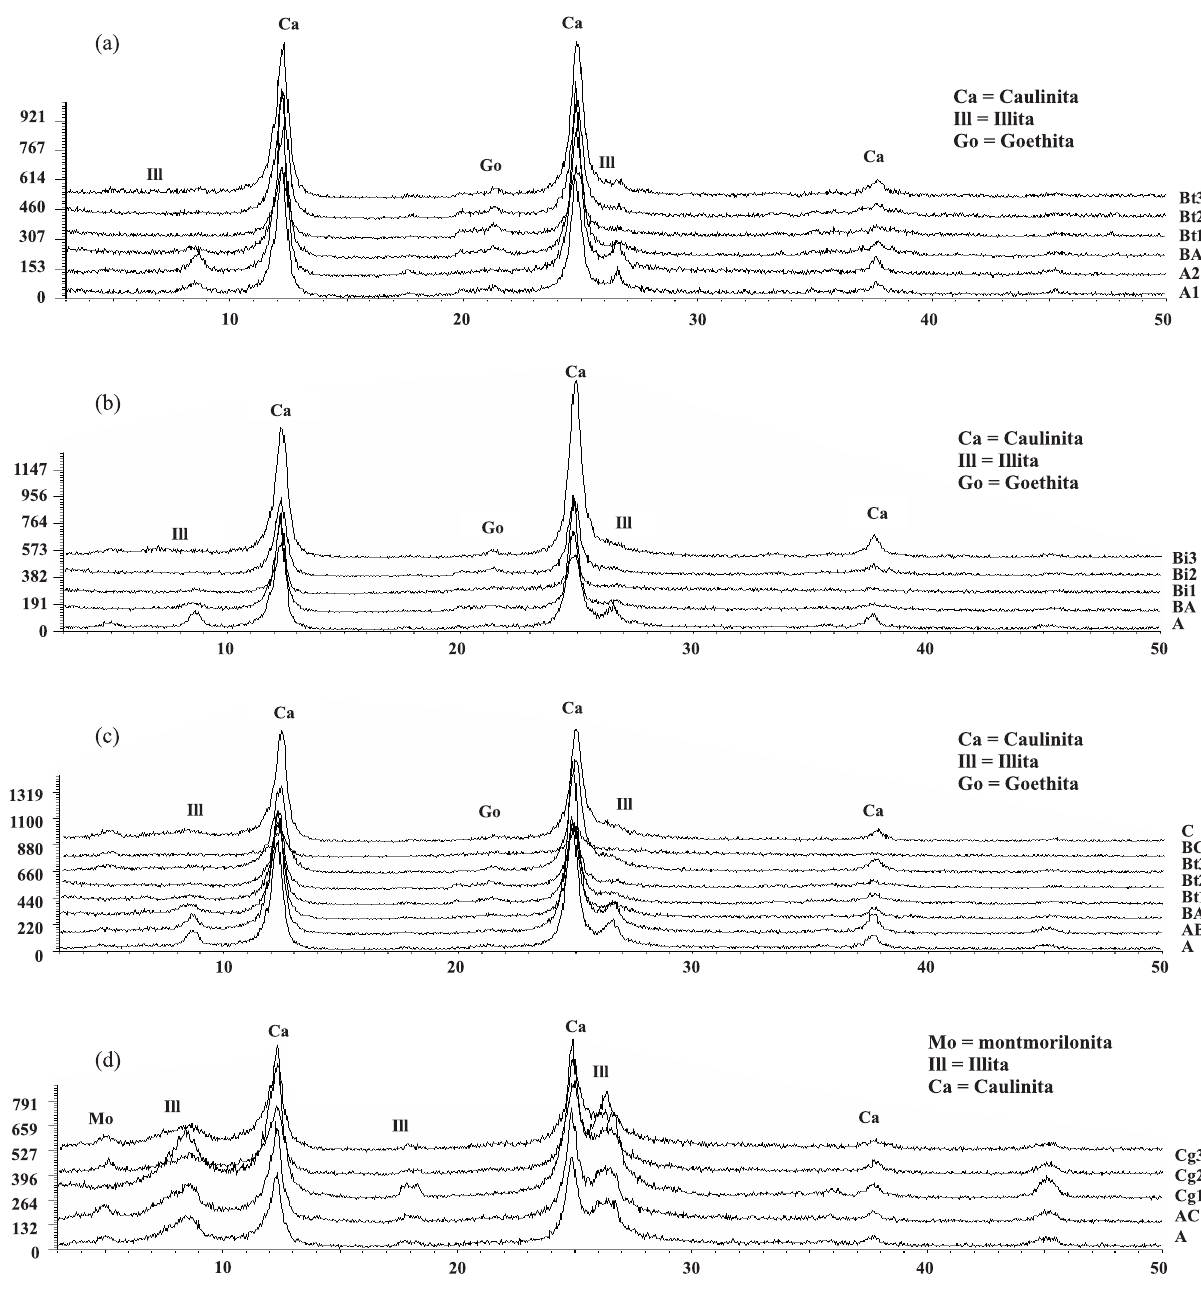
Figura 3. Difratogramas de raios X da fração argila do Argissolo Vermelho (P2) (a); fração argila do Cambissolo Háplico (P3) (b); fração argila do Argissolo Amarelo (P4) (c); fração argila do Gleissolo Háplico (P5)